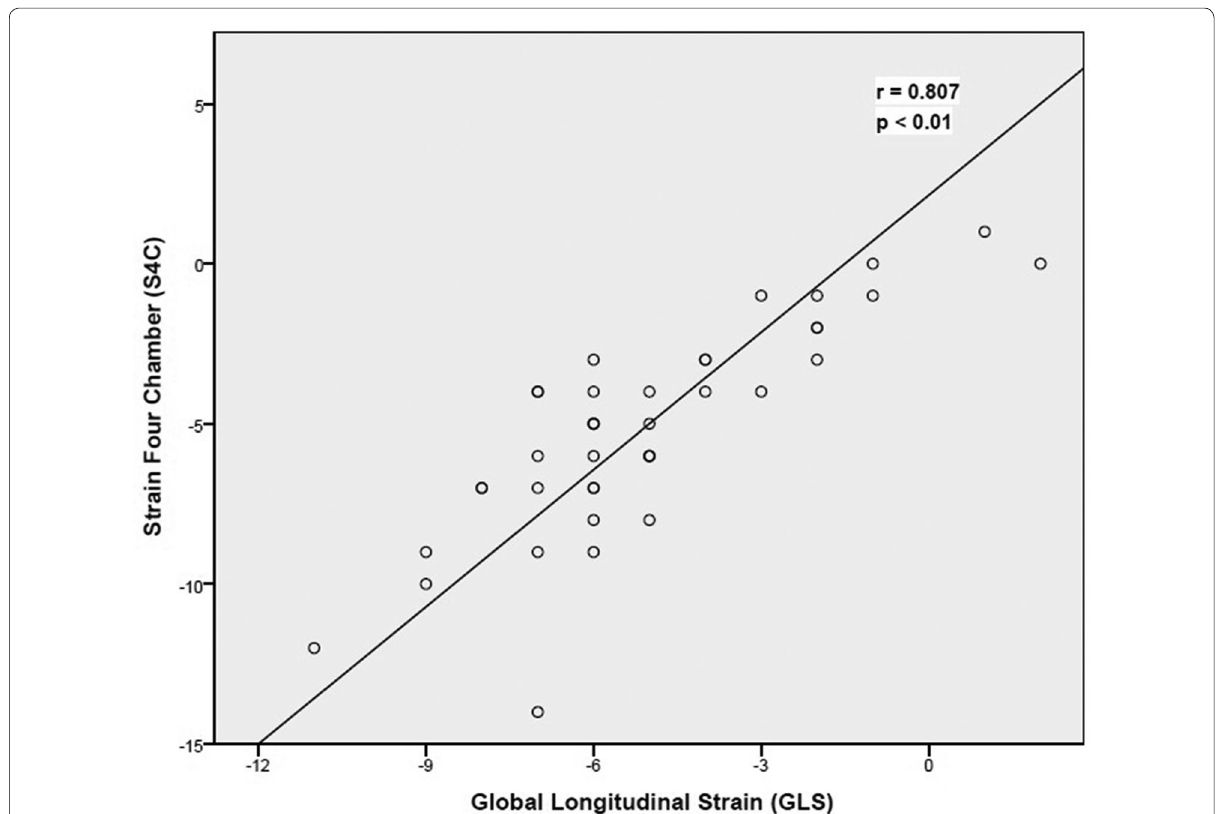
Fig. 4 Correlation of global longitudinal strain and strain 4 chamber r